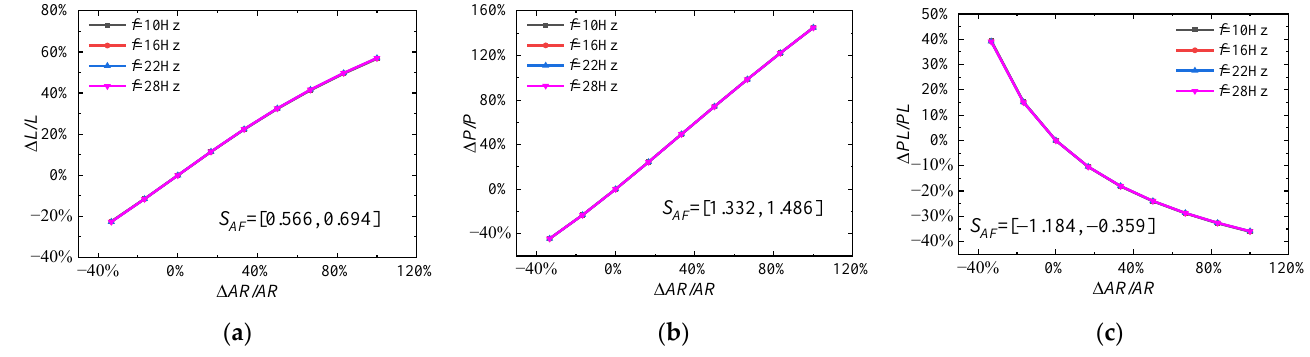
Figure 5. Sensitivity analysis for AR . The value of S AF is given as an interval between the minimum and maximum values. ( a ) Variation of lift vs. variation of AR . ( b ) Variation of aerodynamic power vs. variation of AR . ( c ) Variation of PL vs. variation of AR .